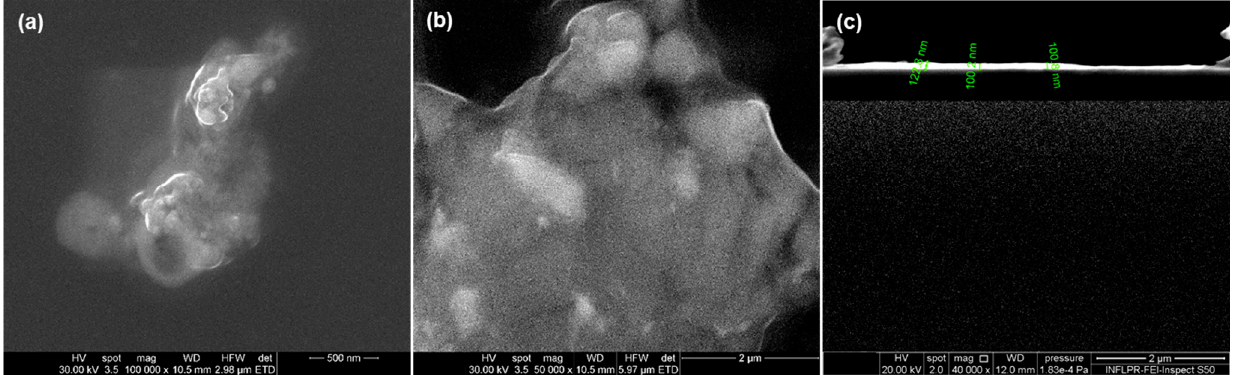
Figure 14. SEM micrographs of the thin coatings ( a , b ) and cross-section ( c ) prepared at 300 mJ/cm 2 laser fluence.